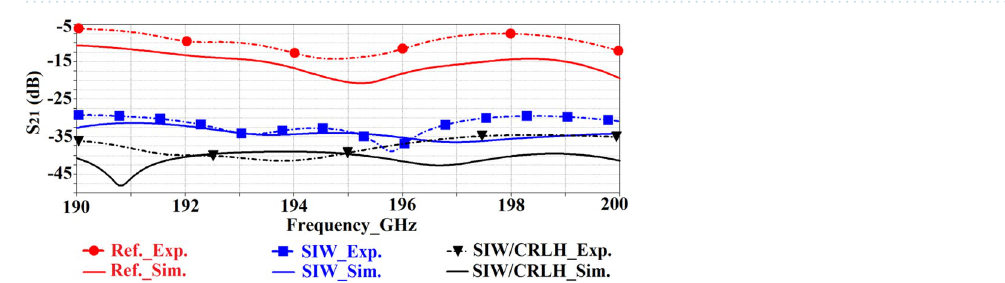
Figure 14. Simulated and experimental results of the transmission-coefficient (S 21 ) of the reference, SIW- loaded, and SIW-loaded MTM (CRLH) antenna arrays.